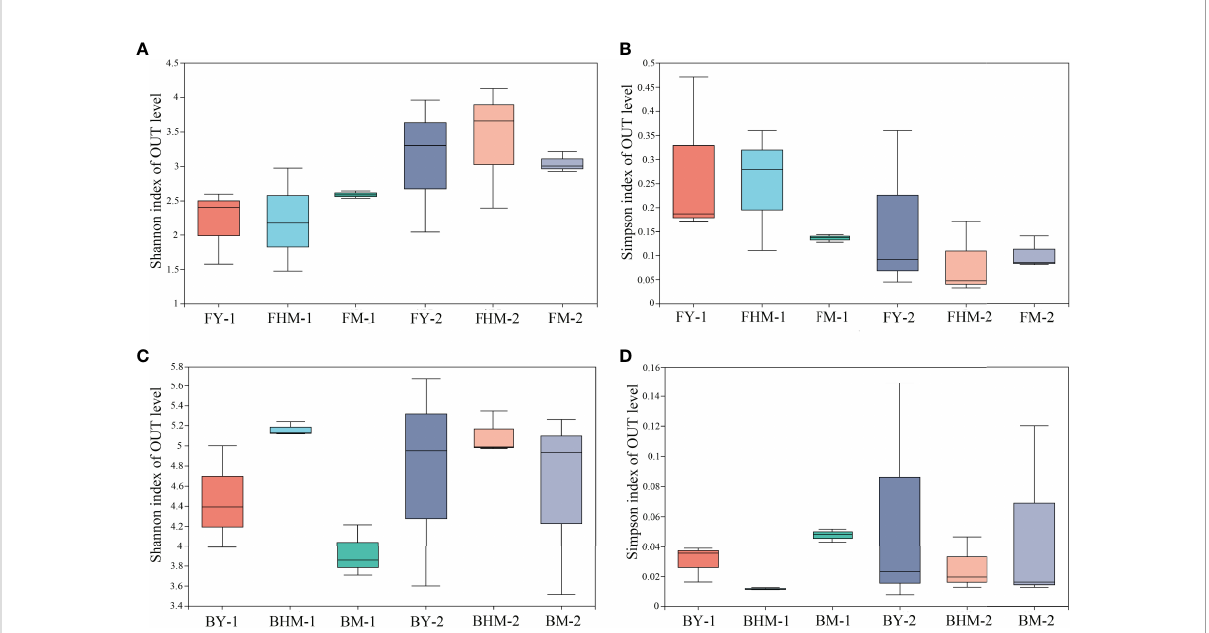
FIGURE 5 Boxplots showing the Shannon and Simpson indices of the fungal and bacterial communities within different plantation ages. FY-1, FHM-1, FM-1 are the endophytic fungi of the young, half-mature, and mature plantation; FY-2, FHM-2, FM-2 are epiphytic fungi of the young, half-mature, and mature plantation; BY-1, BHM-1, BM-1 are endophytic bacteria of the young, half-mature, and mature plantation; BY-2, BHM-2, BM-2 are epiphytic bacteria of the young, half-mature, and mature plantation. The same bellows. (A) shannon index of OTU level of fungi; (B) simpson index of OTU level of fungi; (C) shannon index of OTU level of bacteria; and (D) simpson index of OTU level of